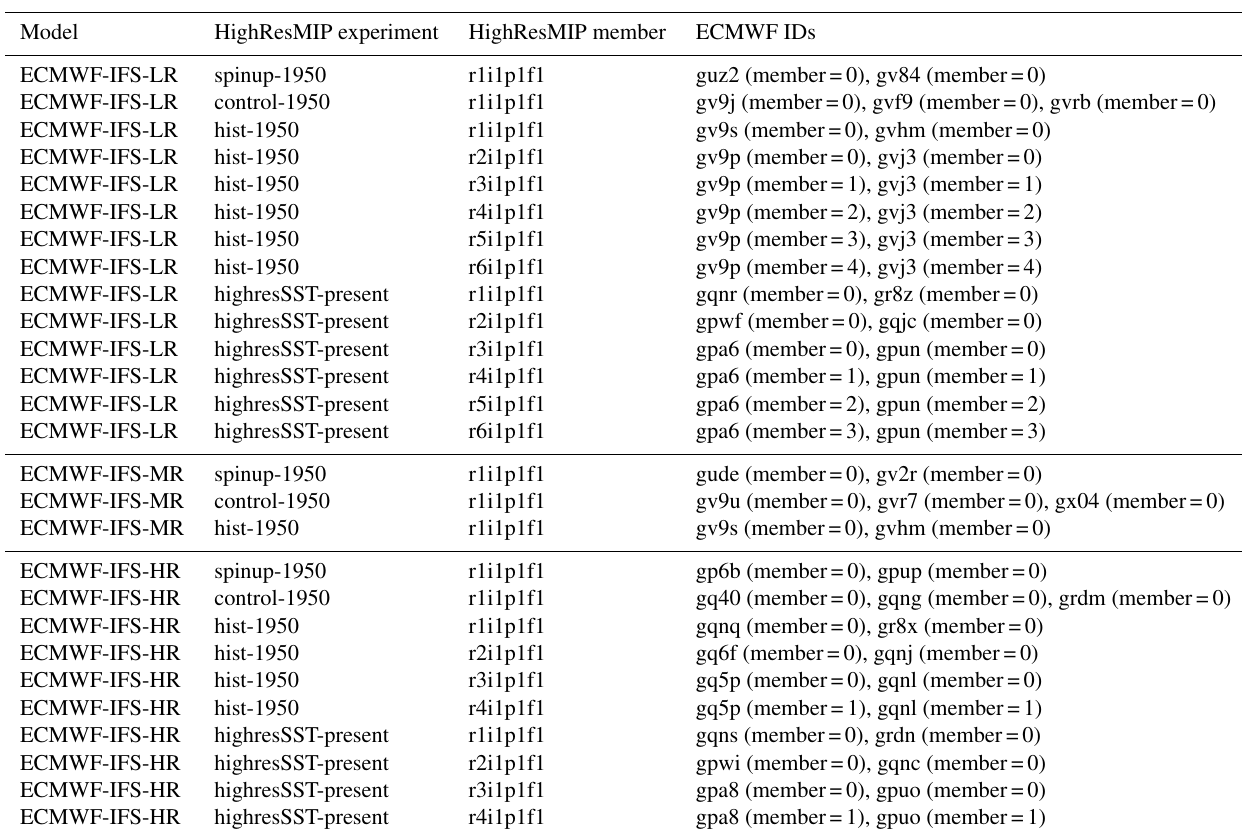
Table A2. Mapping between ECMWF-IFS HighResMIP experiments and internal ECMWF experiment identifiers.